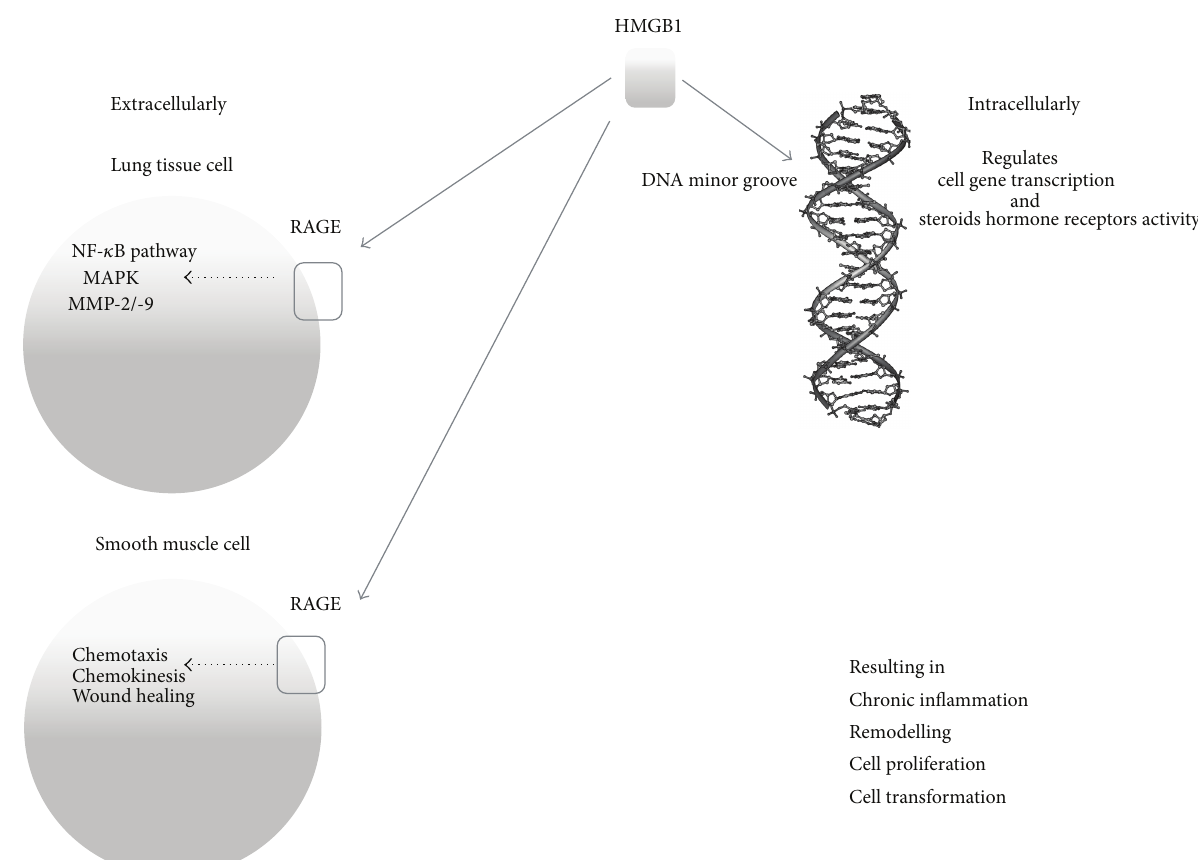
Figure 2: Intracellular and extracellular HMGB1 main